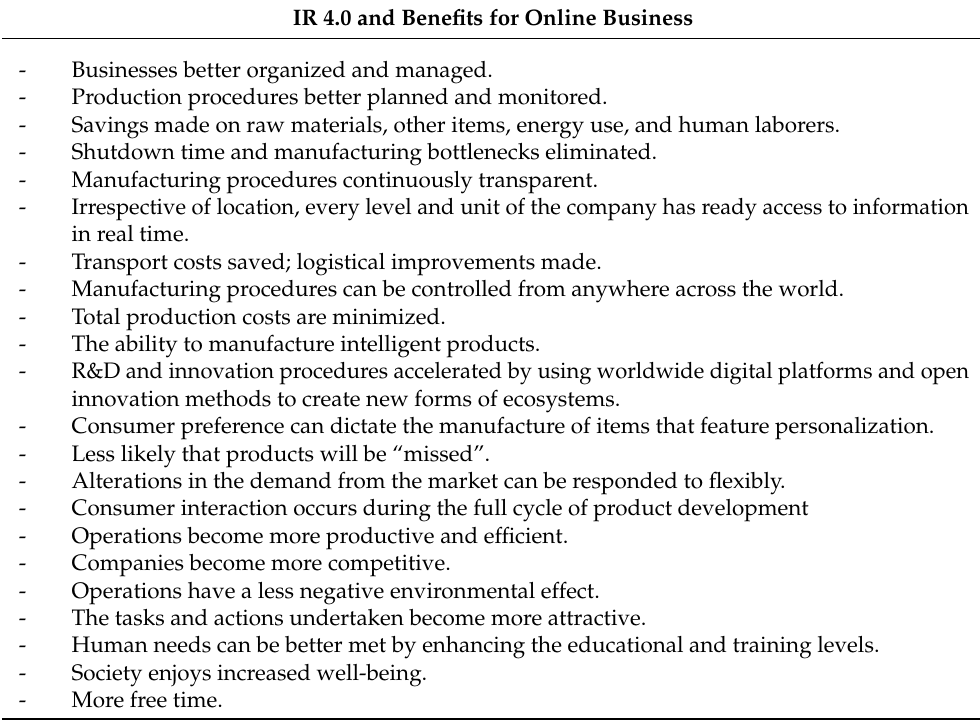
Table 1. Benefits of online business in the IR 4.0